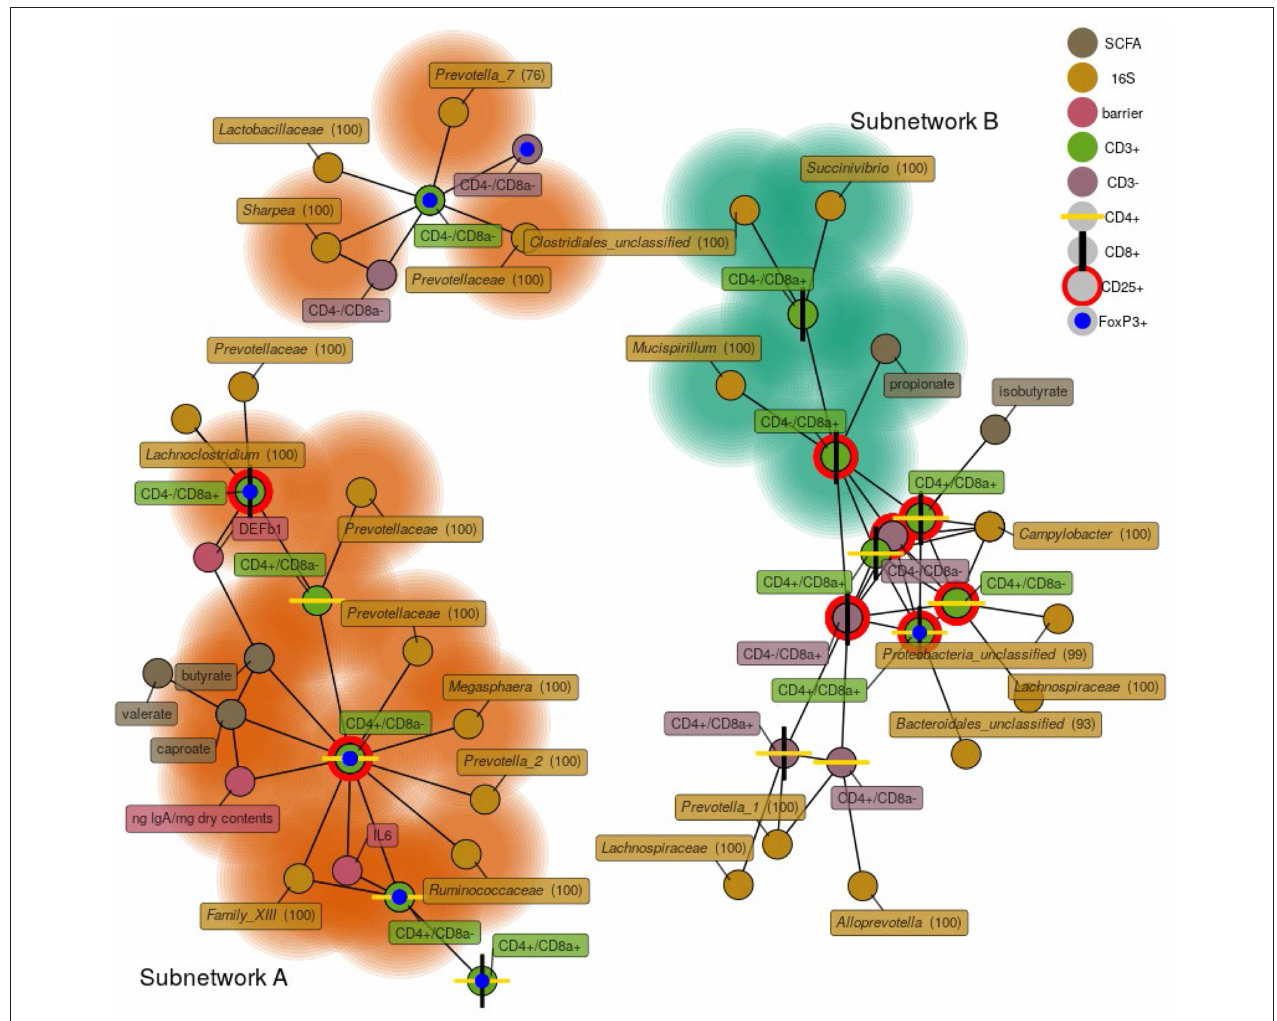
FIGURE 8 | A network depicting correlations among cecal immune cells, 16S rRNA gene OTUs, cecal SCFA concentrations, cecal host mRNA expression, and cecal IgA concentrations. Only positive correlations are shown with a Spearman coefficient > 0.6 and a p < 0.05. Bacterial nodes are OTUs labeled with their taxonomic classification according to the SILVA database. Labels are genus names except when no classification at the genus level was possible, in which case family names are shown. Nodes shaded with green are features that are enriched in the CON group, nodes shaded in orange are those enriched in the RPS